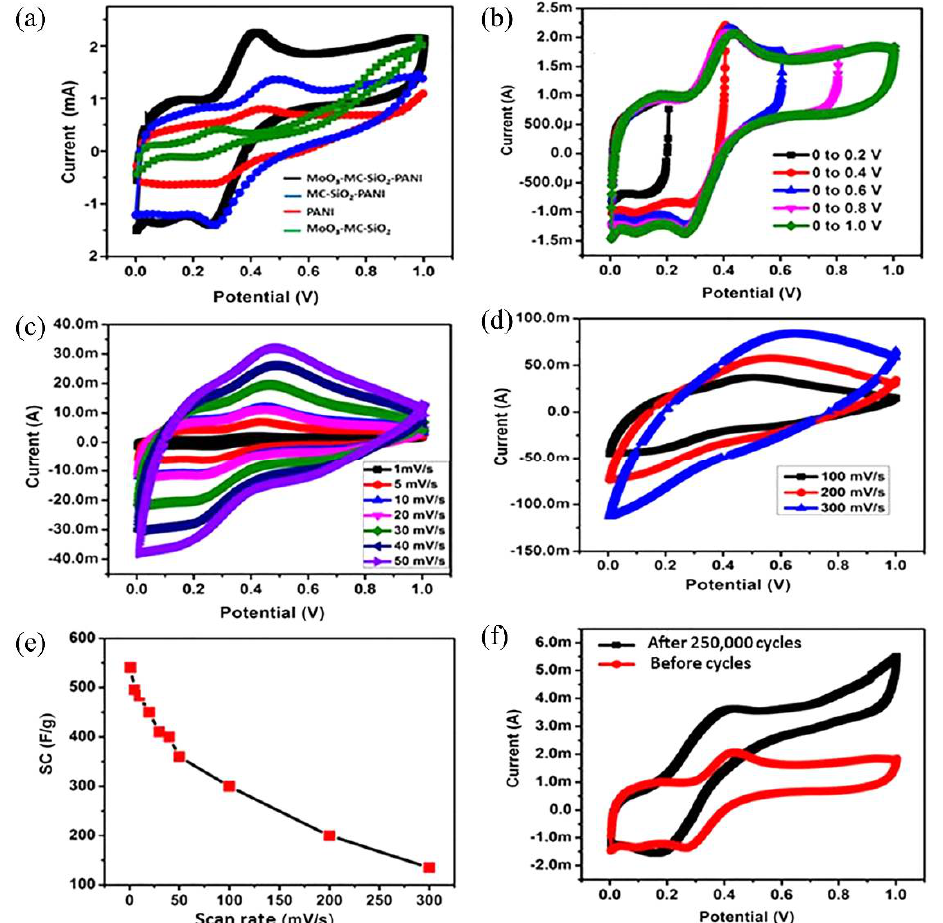
Figure 5. ( a ) CV curves of MoO 3 –MC–SiO 2 –PANI, MC–SiO 2 –PANI, PANI, and MoO 3 –MC–SiO 2 at 1 mV/s scan rate; ( b ) CV curves in different voltage ranges of MoO 3 –MC–SiO 2 –PANI at 1 mV/s scan